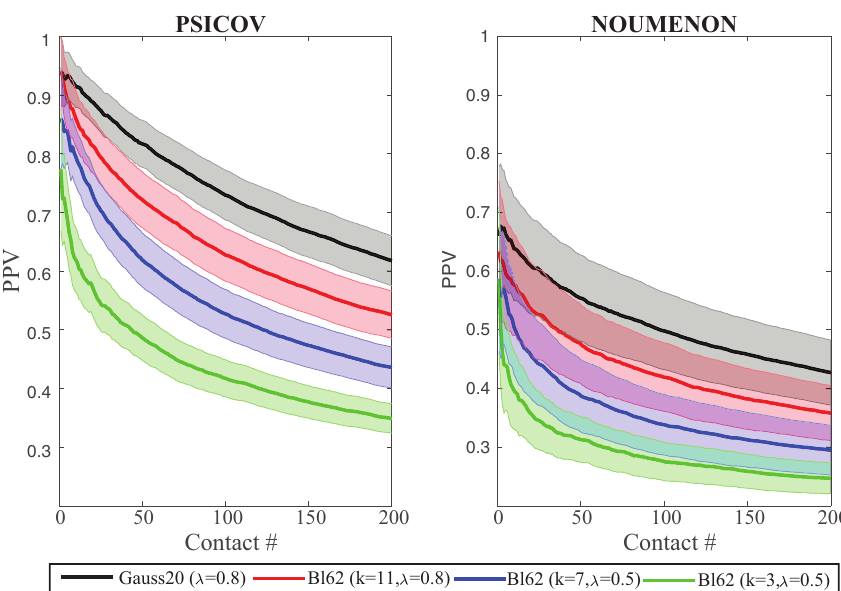
Figure 7. Precision Positive Values (PPV) plotted against the number of predicted contacts or the PSICOV dataset ( left ) and the NOUMENON dataset ( right ). Data were generated with GaussCovar, with amino acids represented with coordinates derived from the k principal components of the BLOSUM62 matrix. We show results for k = 3, λ = 0.5 (green), k = 5, λ = 0.5 (blue), and k = 11, λ = 0.7 (red). Data for GaussCovar with the 20D binarized encoding are shown in black for comparison. All PPV curves are arithmetic means over 150 protein families (see caption of Figure 1 for details). Shaded areas represent standard deviations.